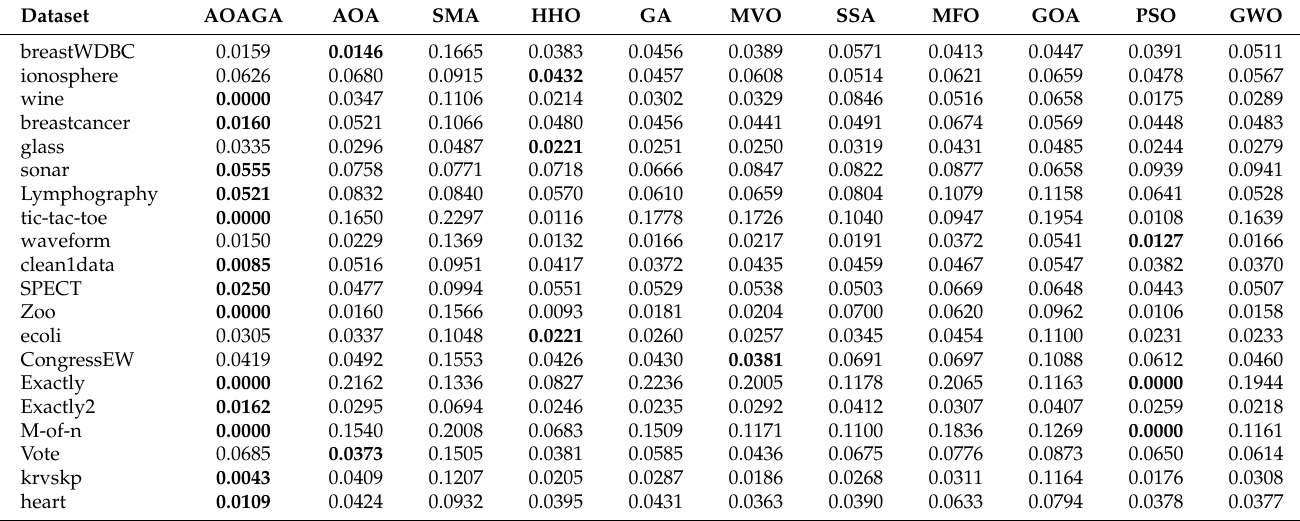
Table 5. Results of the standard deviation for all methods.